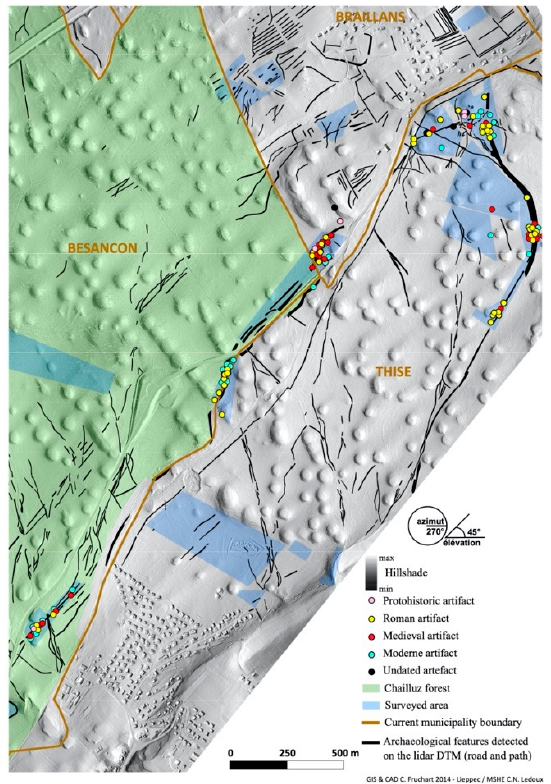
Figure 1. A lidar-derived terrain model with the courses of road axes and tangled paths located in the south-east of the Chailluz massif (Besançon, France) depicted. Location of the surveyed areas and uncovered remains: Lat. 47.28 to 47.31° N–Long. 6.06 to 6.09° E. Source: Lieppec—C. Fruchart [26].